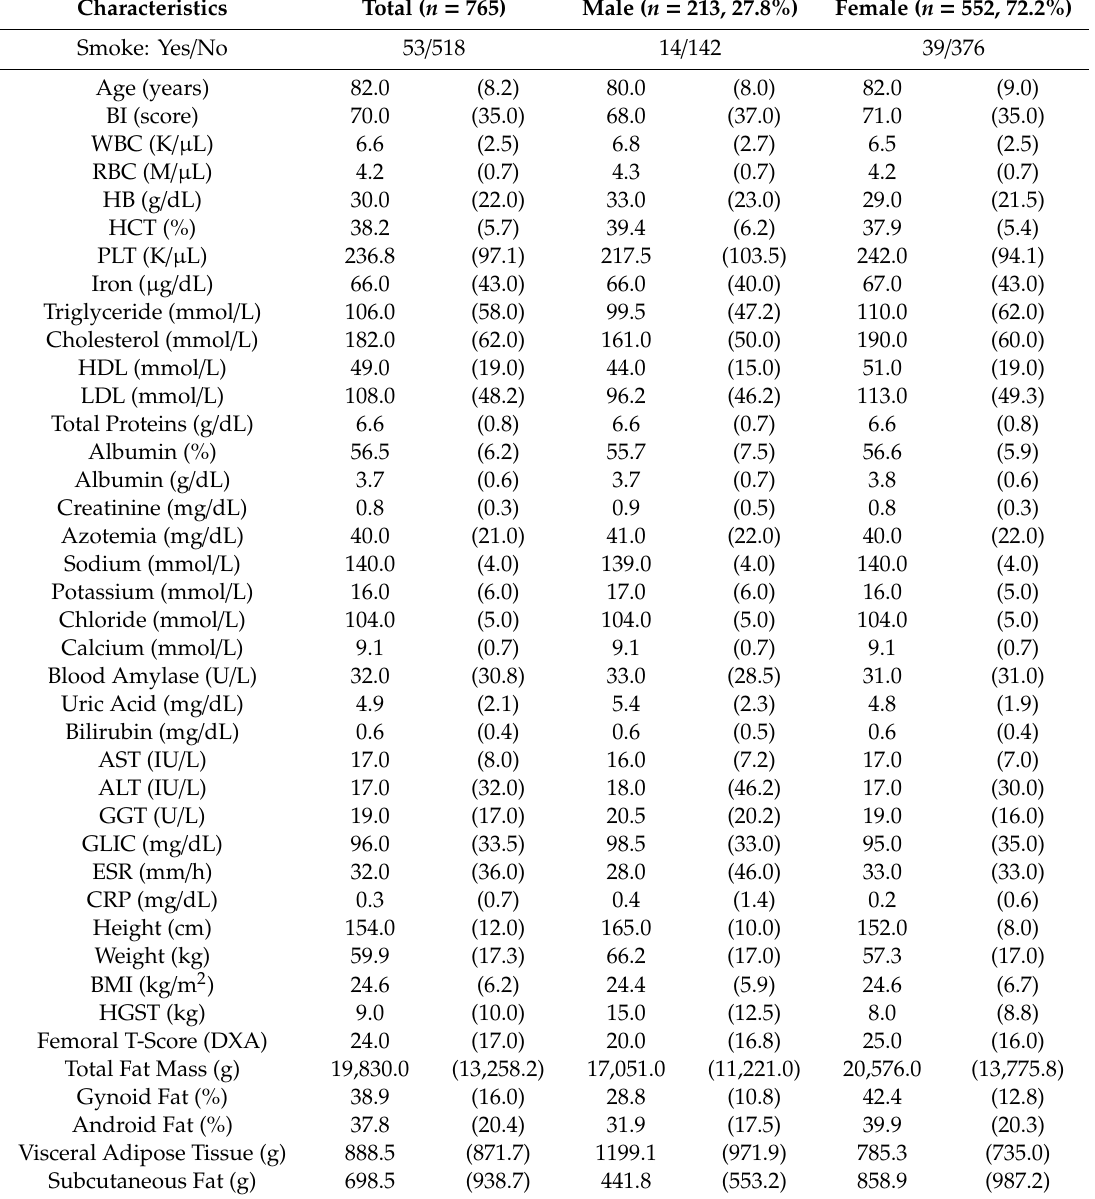
Table 1. The patients’